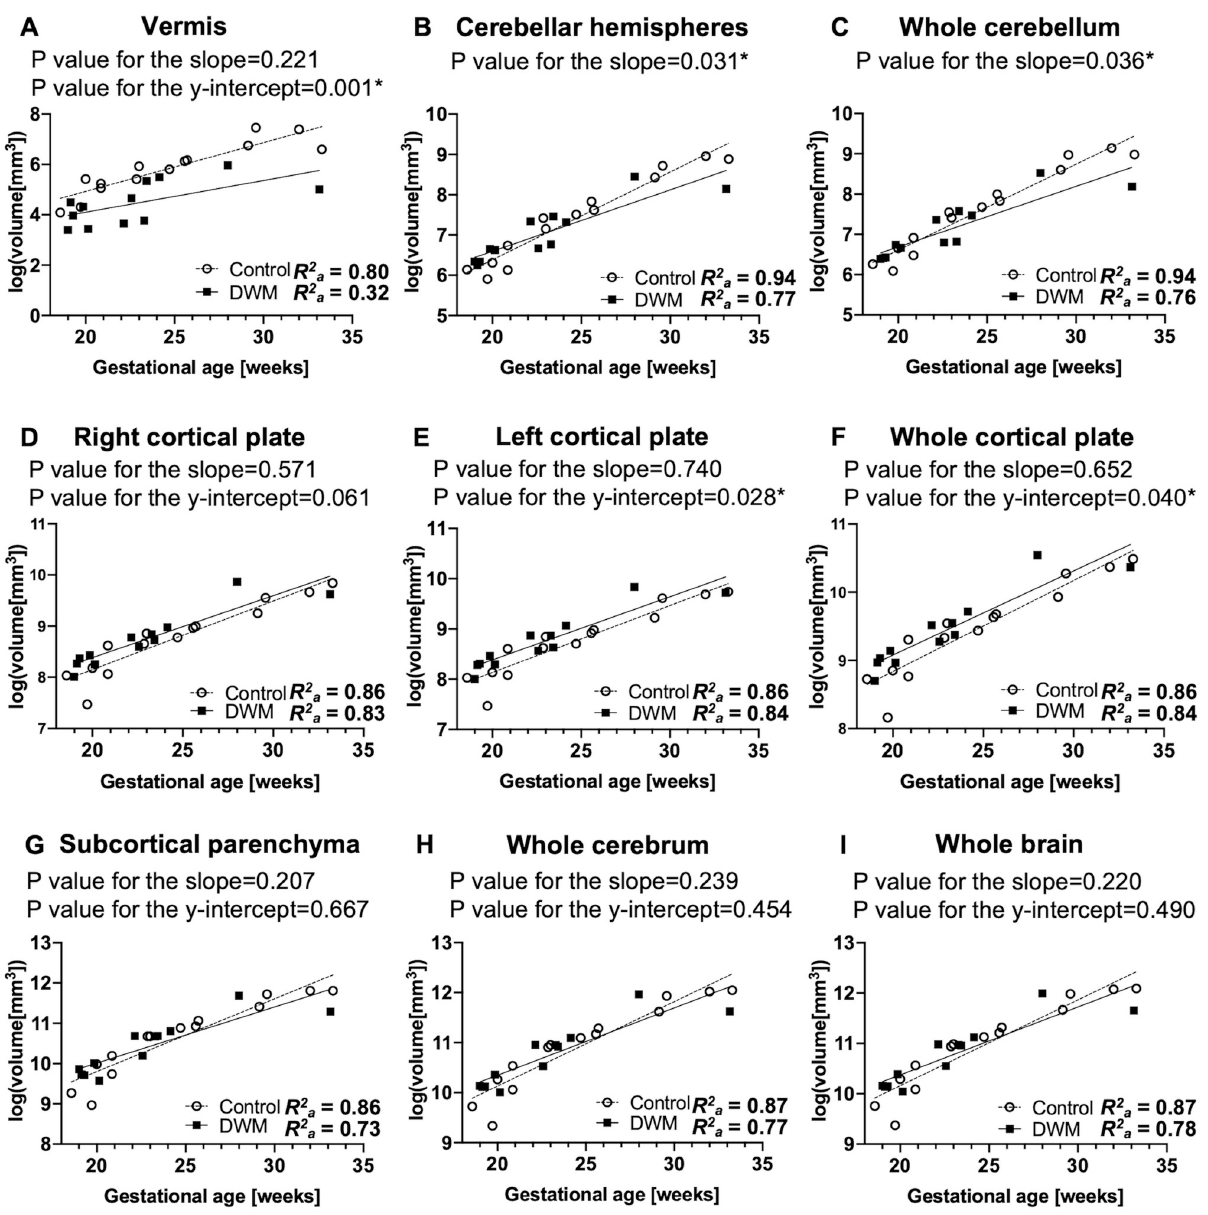
Fig 2. Regional growth trajectories in fetuses with DWM (n = 12) and control fetuses (n = 14). Growth patterns of each regional volume were modeled and compared between fetuses with DWM and control fetuses. A logarithmic transformation of the volume data was performed before fitting the linear regression model in both the DWM and control groups. The growth trajectory of the vermis (A) was significantly smaller in fetuses with DWM than in control fetuses. Fetuses with DWM exhibited reduced rate of growth in the cerebellar hemispheres (B) and whole cerebellum (C) compared to controls. In contrast, growth trajectories of the left cortical plate (E) and whole cortical plate (F) were significantly larger in fetuses with DWM than in control fetuses. No significant differences were observed between fetuses with DWM and control fetuses in growth patterns of the right cortical plate (D), whole subcortical parenchyma (G), whole cerebrum (H), and whole brain (I). segmentation using raw MR images in small structures, the volumes of vermis and cerebellar hemispheres on both reconstructed volume images (3D images) and raw MR images (2D images) in the same brain were compared among five participants (BM84, BCH_CM01, BCH_CM02, BCH_CM06, and BCH_CM09) using the Wilcoxon signed-rank test. There were